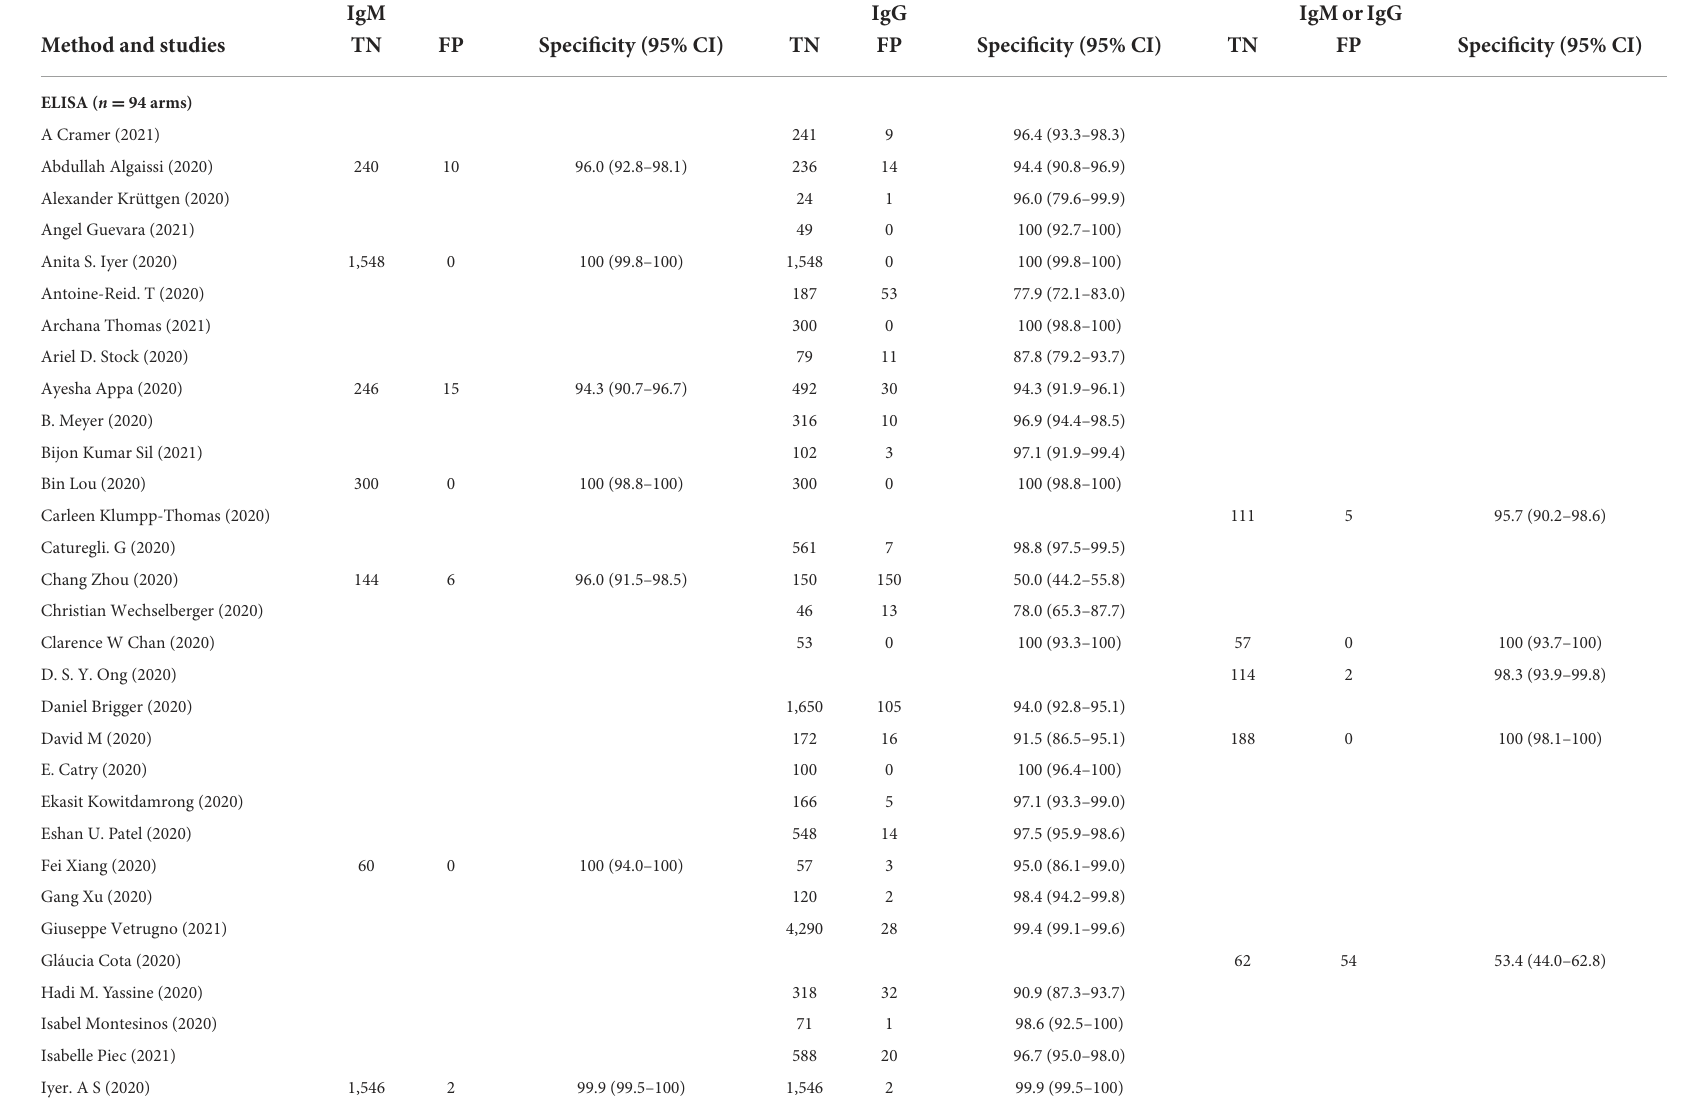
TABLE 3 Individual and pooled specificity by serological test method and immunoglobulin class